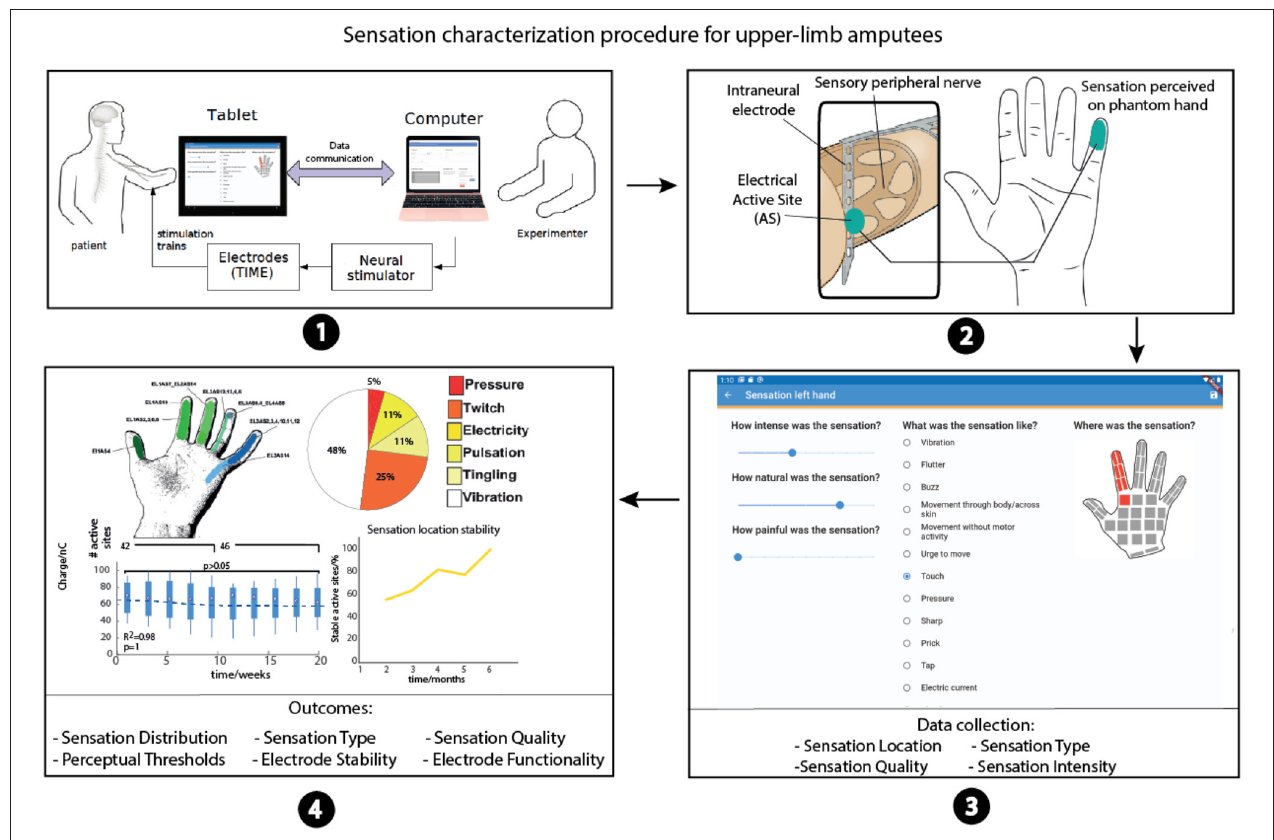
FIGURE 2 | Sensation characterization procedure. (1) Stimulation parameters are selected. The stimulation trains are delivered using the neurostimulator; the software also sends control commands to the Easy Quest app. (2) Patient perceives a stimulation-evoked sensation on the phantom hand thanks to the neural implant. (3) Easy Quest app in ODF mode is used to report the sensations. (4) Experimenters collect all sensation characterization outcomes and import them in MATLAB or Excel to plot the